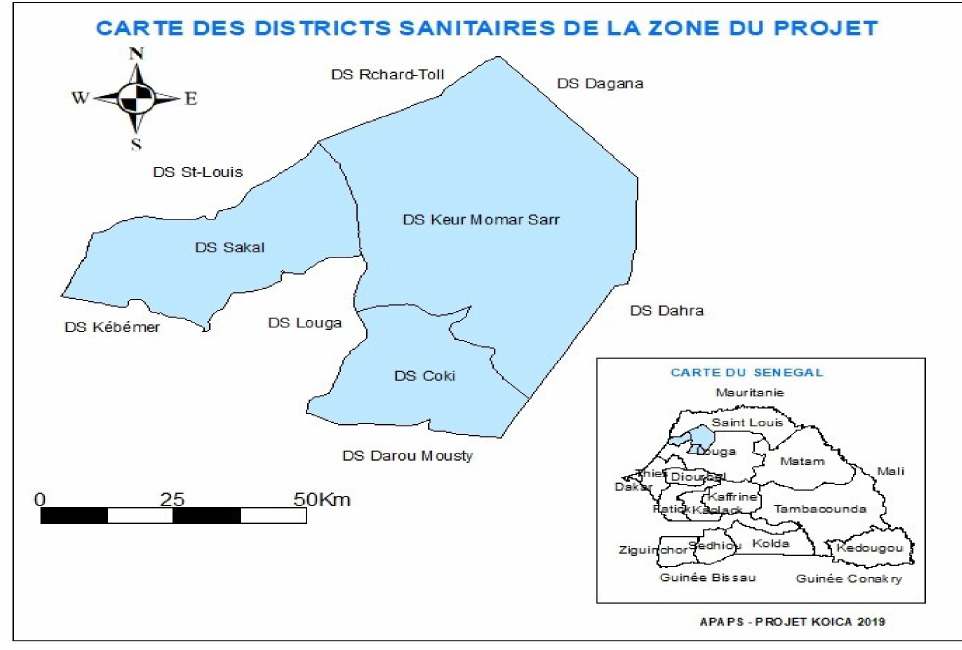
Figure 1. Area of the